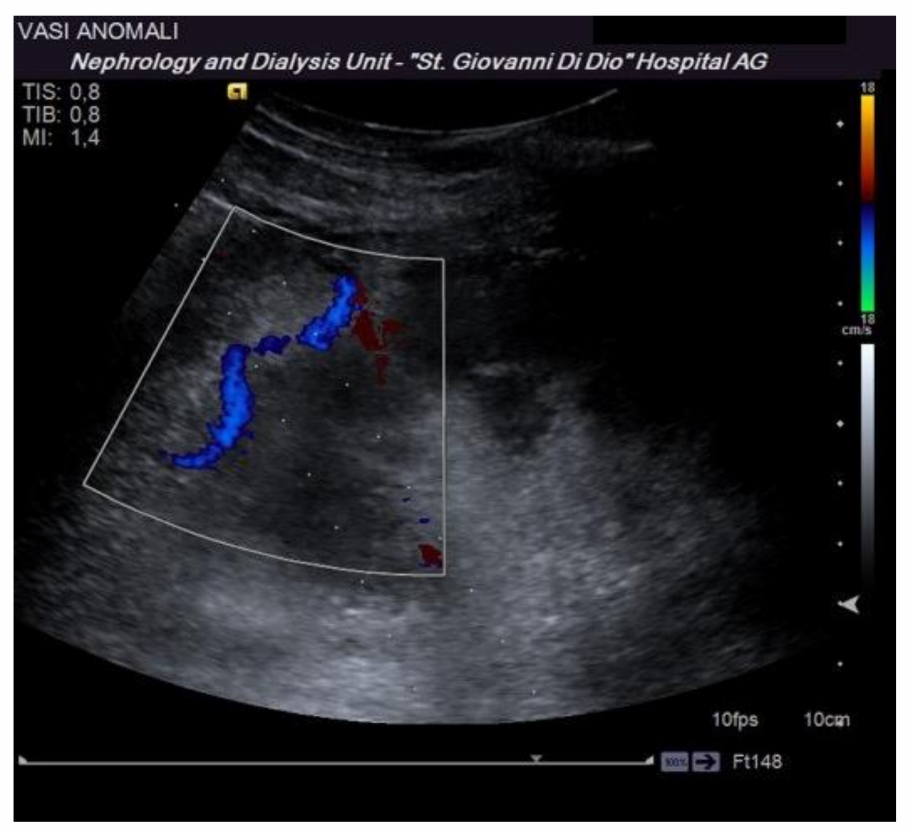
Figure 3. The dotted lines show the expected trajectory of the needle when correctly fixed to the appropriate support. At the lower pole of the kidney, the site of the biopsy, there is an abnormal vascular formation that would have been crossed by the needle if it had not been